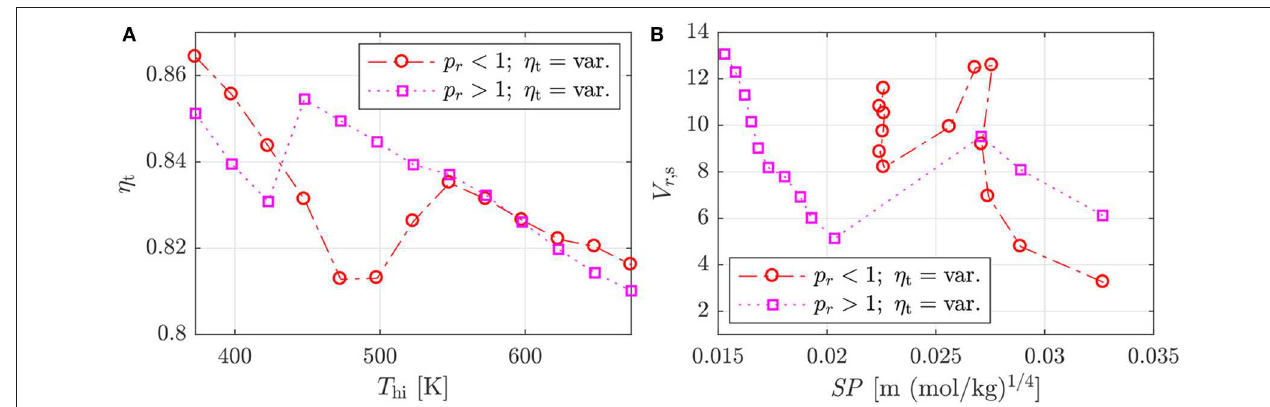
Frontiers in Energy Research |